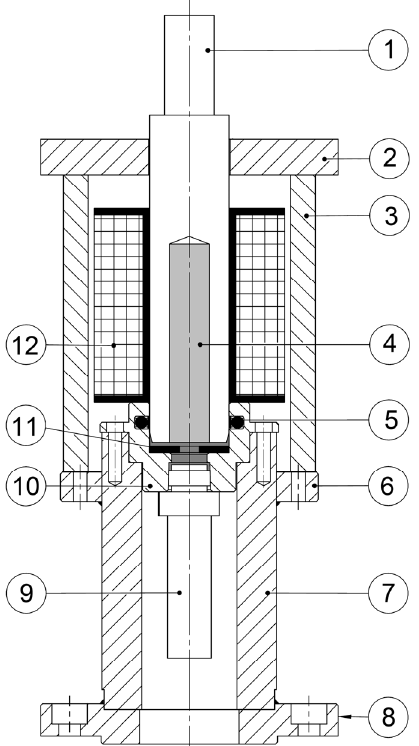
Figure 1: Cross-section of the hydraulic